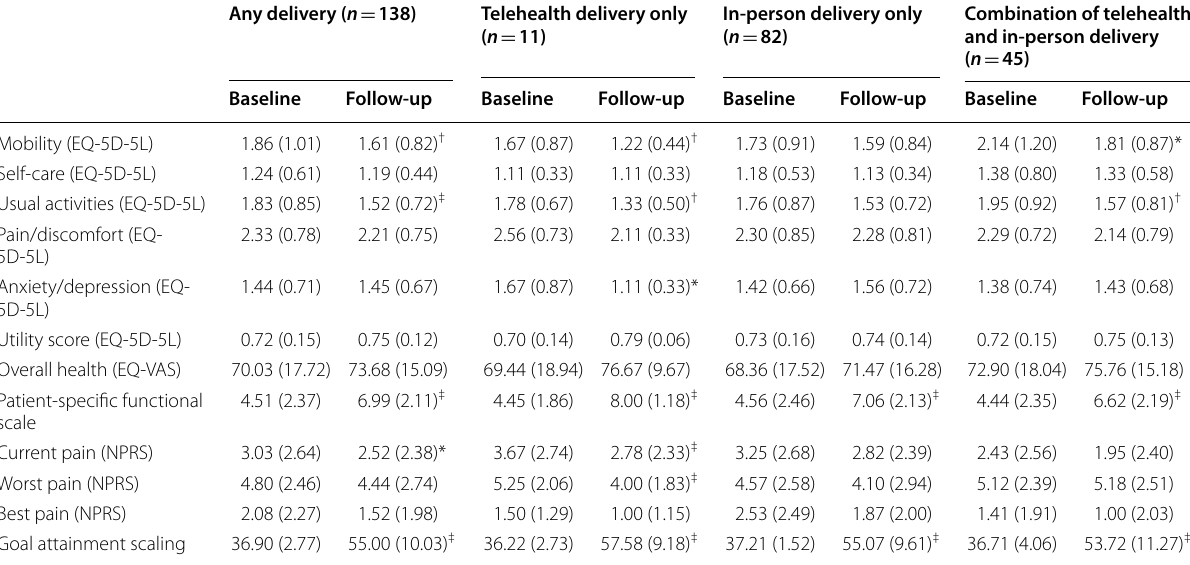
Data are mean (SD). NPRS: Numeric pain rating scale. * P < 0.05; † P < 0.01; ‡ P < 0.001 compared to